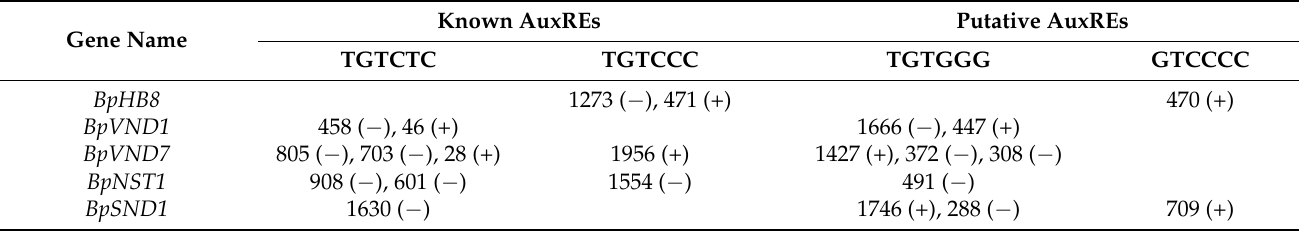
Table 4. Presence of known and putative AuxRE cis -elements in promoters of studied B. pendula genes. Numbers indicate the distance from the start of transcription, plus or minus in brackets shows